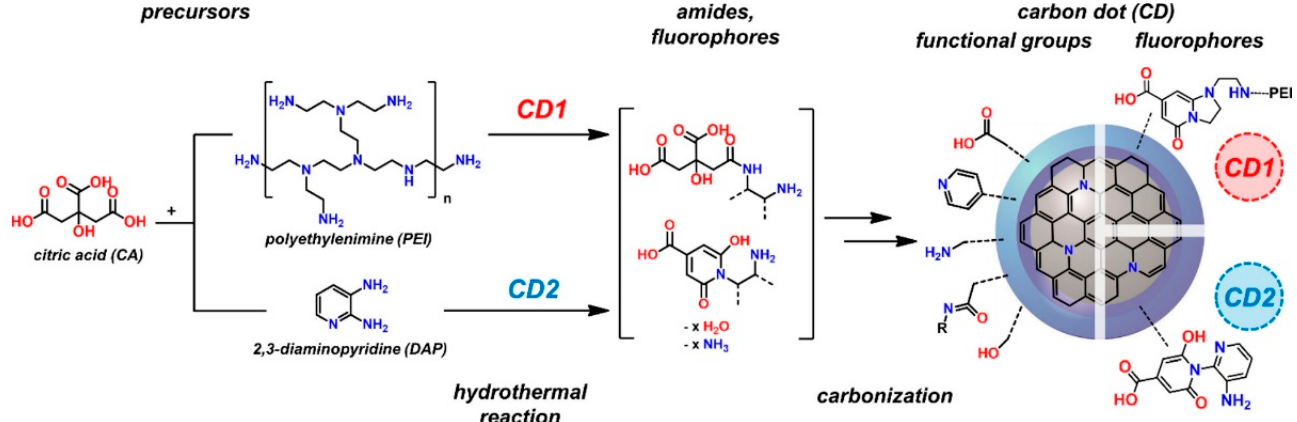
Figure 2. The preparation of CD1 and CD2 by the solvothermal pyrolysis of citric acid and amine precursors PEI and DAP, respectively (reprinted with permission from [94], 2020, American Chemical Society).